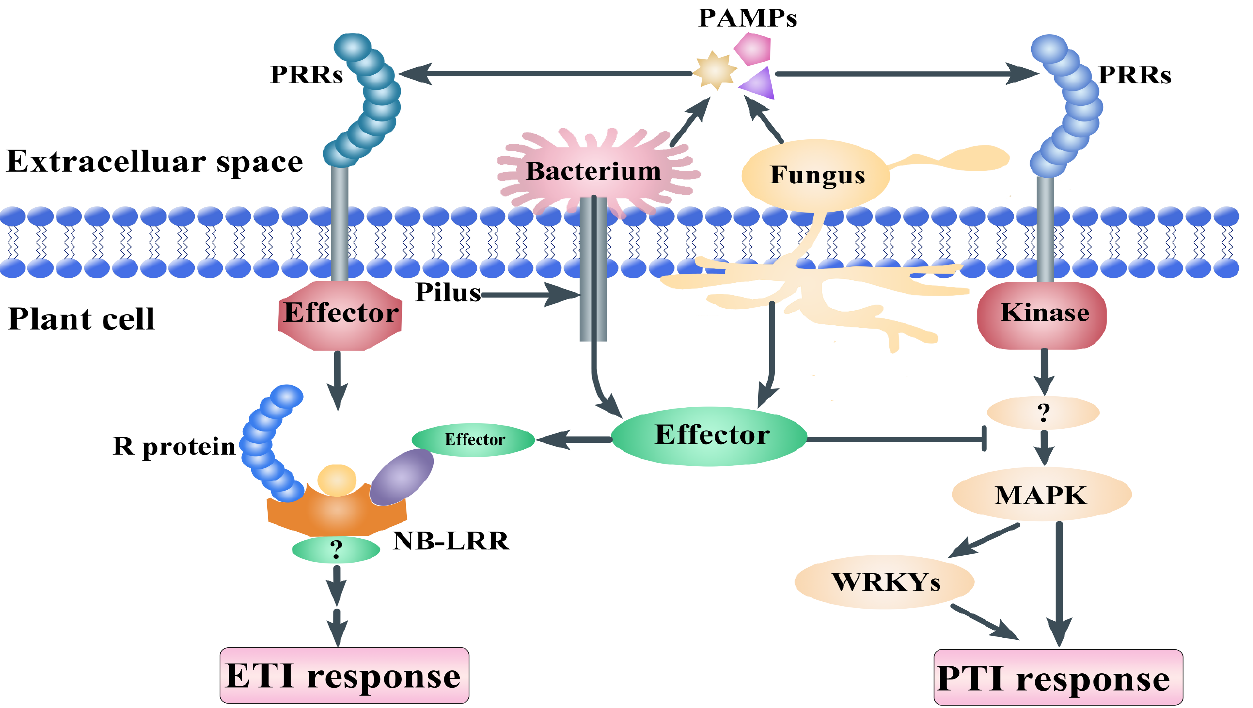
Figure 1. Plant immunity principles. Pathogen-associated molecular patterns (PAMPs) are molecules released from pathogens, such as chitin and flagellin. Pattern recognition receptors (PRRs) can recognize the PAMPs from the pathogens and transmit signals to mitogen-activated protein kinases (MAPKs) and WRKY transcript factors, which induce PAMP-triggered immunity (PTI) response. Pilus is a tool that delivers bacterial effector proteins into the host cell. PRRs consist of the leucine-rich repeat (LRR) domain and are recognized by nucleotide-binding site (NB)-LRR receptors, which induce effector-triggered immunity (ETI). NB-LRR proteins consist of an LRR domain, a NB domain, and an amino-terminal Toll/interleukin-1 receptor resistance protein (TIR) or a coiled-coil (CC) domain.